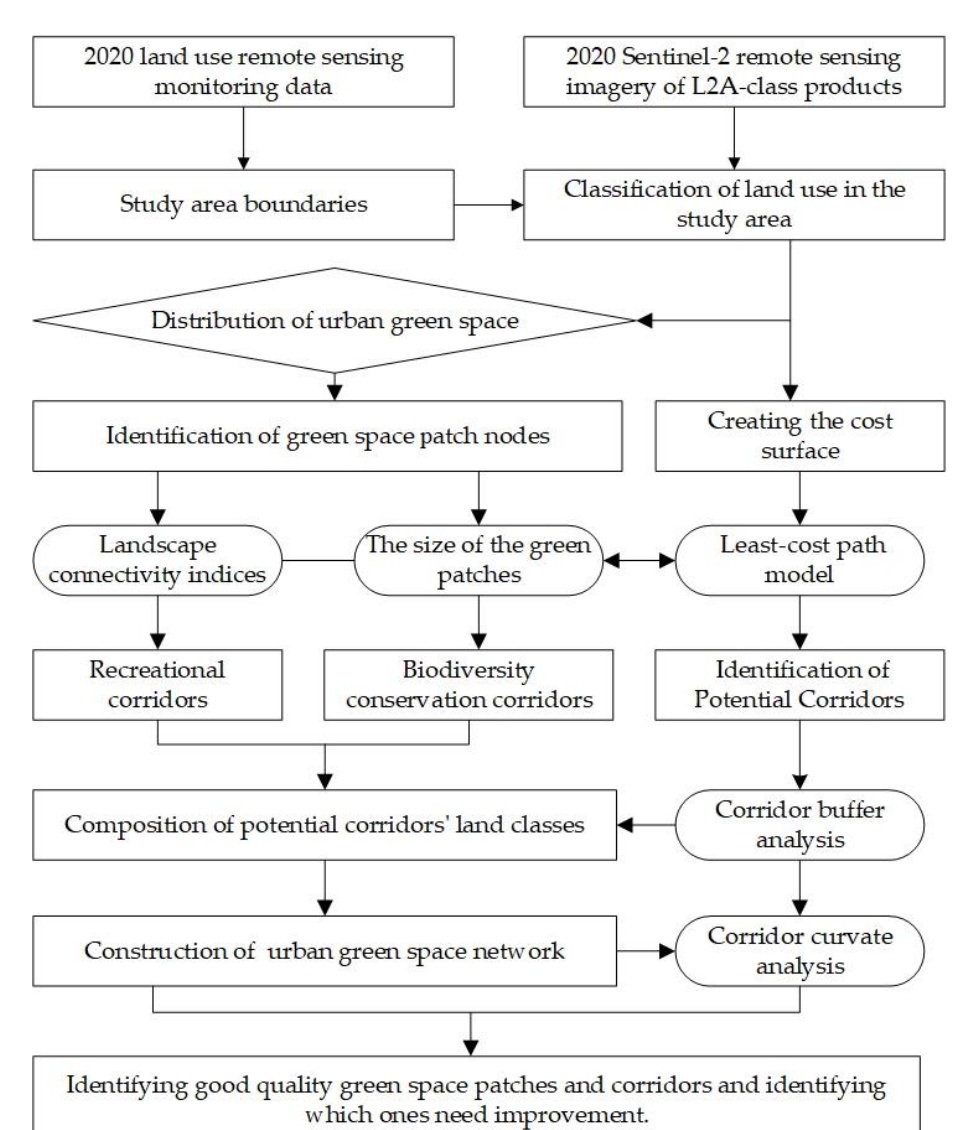
Figure 2. The process used to identify potential corridors and develop an urban green space net- work.